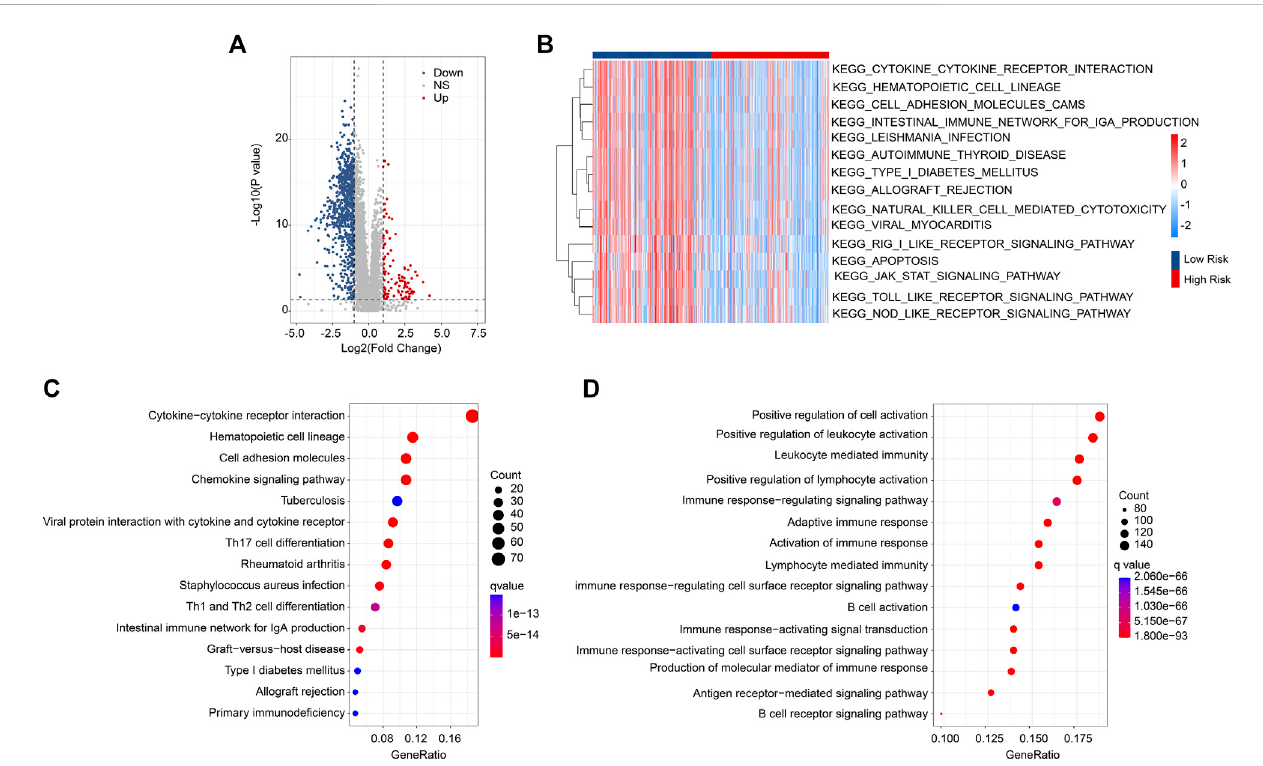
FIGURE 5 DEGFunctionalenrichmentanalysisinthedifferentriskgroups. (A) Volcanodiagramofthesigni fi cantDEGs.Thethreshold:|FC| ≥ 2and p < .05. (B) GSVA analysis shows the KEGG term of CM patients in the different risk groups. (C) The results of KEGG enrichment analysis. (D) GO enrichment analysis illustrates the enriched biological